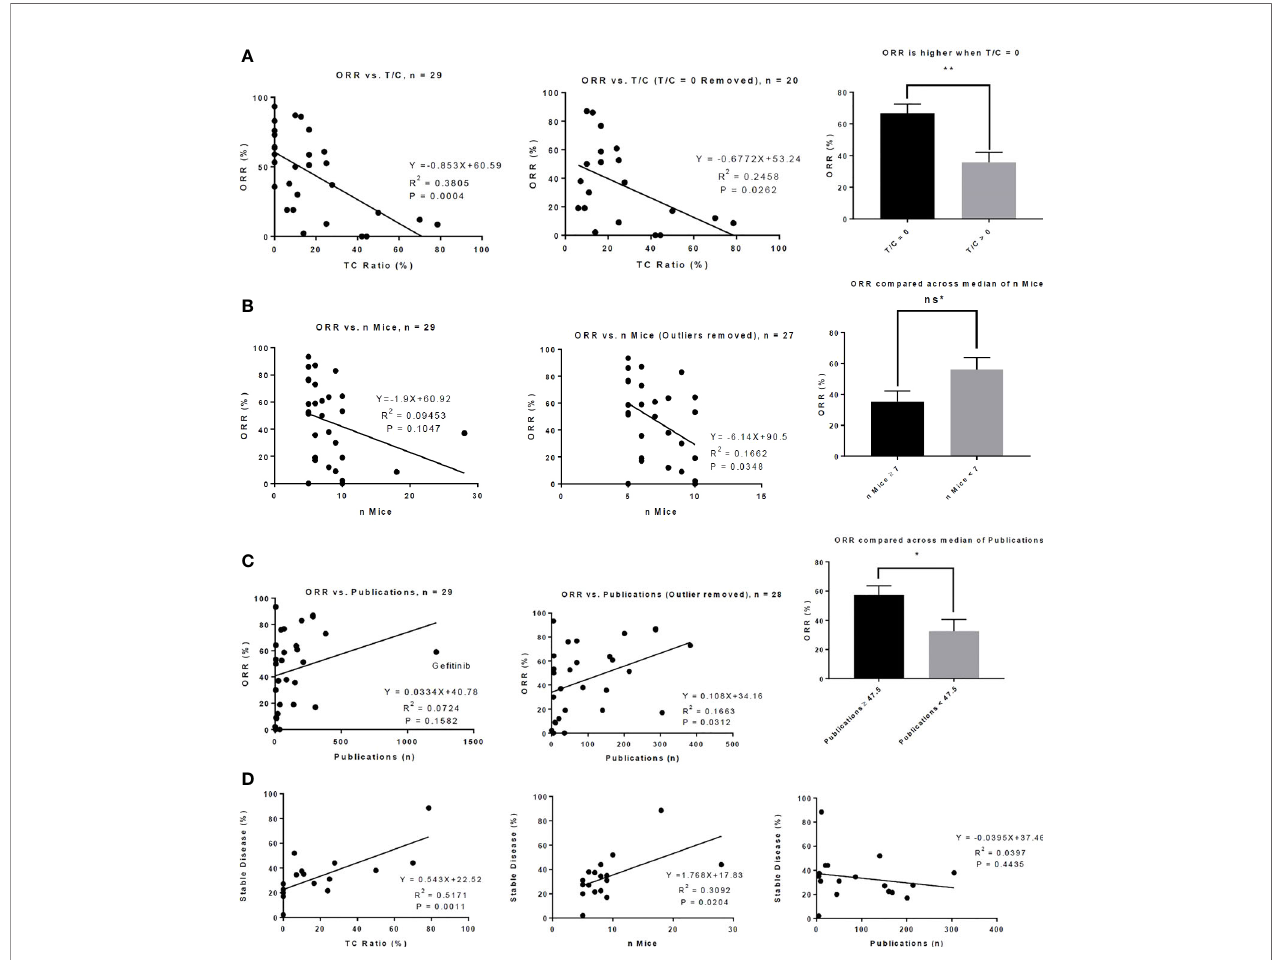
FIGURE 1 | Preclinical metrics associate with activity in phase II clinical trials. (A) There is a signi fi cant correlation between T/C Ratio and objective response rate (ORR) (left) and this correlation remains when drugs that demonstrated a T/C Ratio of 0 in mouse models were removed from the analysis (middle). Drugs that produced a T/C ratio of 0 in mouse models produced a signi fi cantly higher ORR in phase II clinical trials (right). (B) There is a modest correlation between the number of mice who were treated with a drug and the ORR of the drug in phase II clinical trials (left); this correlation becomes signi fi cant when 2 outliers were removed (middle). The median number of mice treated with drug is 7. There was a trend toward signi fi cance in which drugs tested in 7 or more mice produced a lower ORR than drugs tested in fewer than 7 mice. (C) There is a correlation between ORR and the number of publications indexed on PubMed up to the date the phase II clinical trial was published (left); this correlation is increased when 1 outlier (ge fi tinib) was removed (middle). The median number of publications is 47.5; drugs in which 47.5 or more publications were indexed on PubMed up to the date of the phase II trial produced a signi fi cantly higher ORR. (D) Correlations between the percent of patients in the phase II trial who achieved stable disease and T/C ratio (left), number of mice who received drug (middle), and number of publications indexed on PubMed up to the date of the phase II trial (right) are shown. ns* = trend toward signi fi cance with p = 0.0534, *P < 0.05, **P < 0.01, Bar graphs represent means with standard